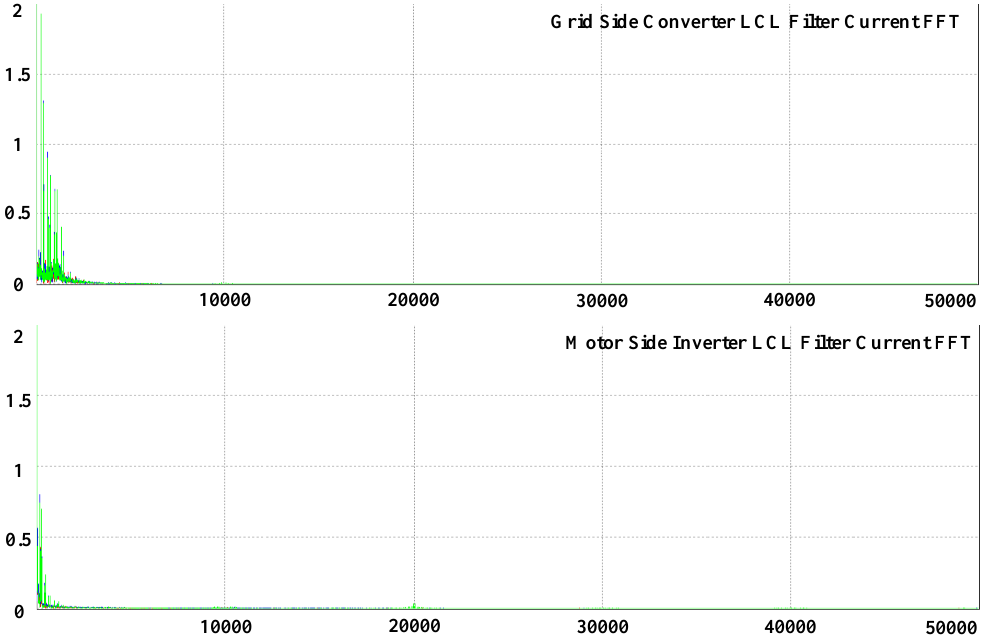
Figure 17. Fast Fourier transform (FFT) analysis results of grid side LCL filter current and motor side current using the conventional SVPWM with the dead time.